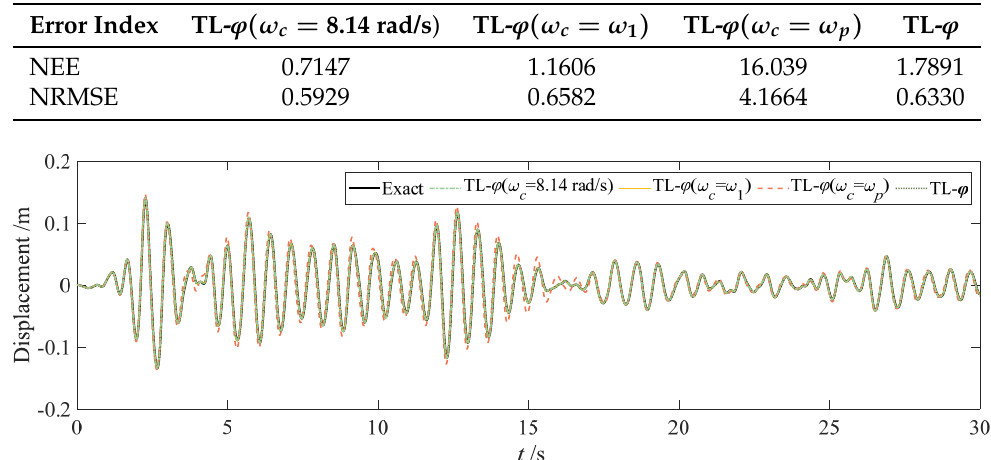
Table 14. Displacement errors for the 4th story.